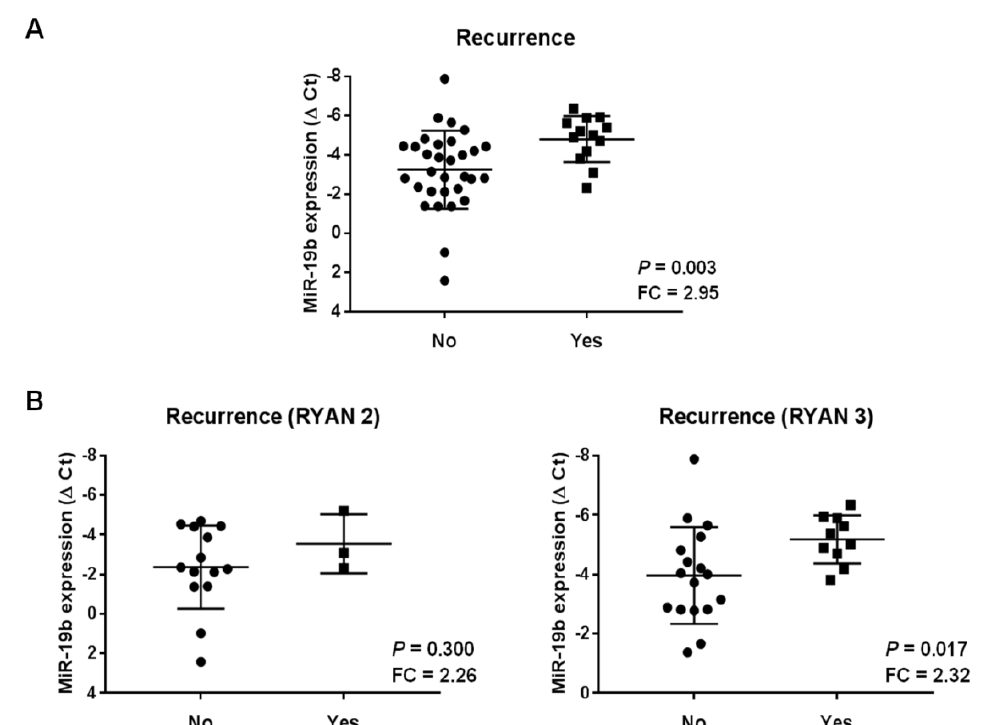
Figure 4. ( A ) MiR-19b expression levels in patients with and without disease relapse in the global cohort and ( B ) after stratification by RYAN status. Patients with low and high miR-19b expression levels are indicated by black squares and circles, respectively. Table 1. Association between patient recurrence and miR-19b expression in post-treatment biopsies from LARC patients.